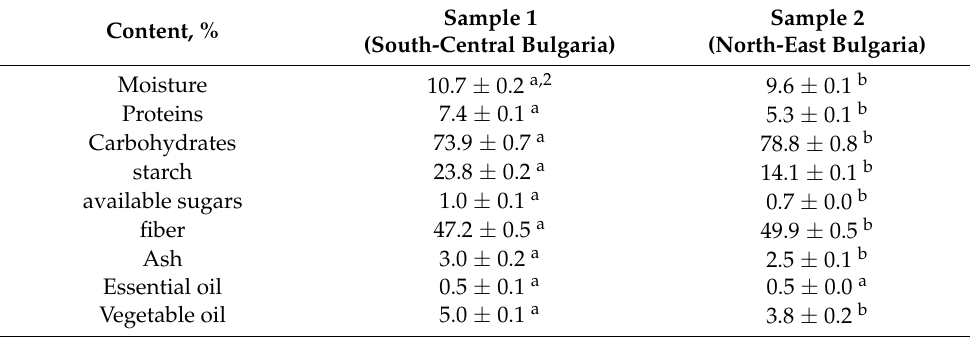
Table 1. Chemical composition of the fruits 1 .